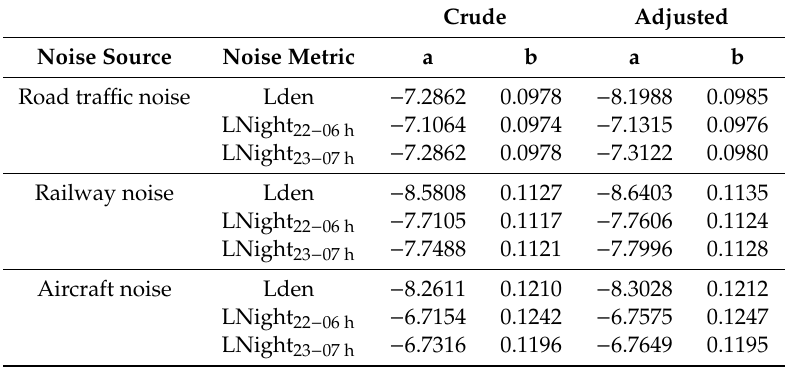
Table 4. Coe ffi cients of logistic equations for P HSD , as derived for the crude and the adjusted model for each noise source, regressed on the maximum façade point values of (i) Lden, (ii) LNight 22 − 06 h and (iii) LNight 23 − 07 h. Covariates in the adjusted models are centered on the mean. To calculate %HSD [%] for a given exposure value x [dB] in the desired noise metric: Insert a, b, and x into the equation %HSD = 100 / (1 + exp( − (a + bx))). Crude Adjusted Noise Source Noise Metric a b a b Road tra ffi c noise Lden − 7.2862 0.0978 − 8.1988